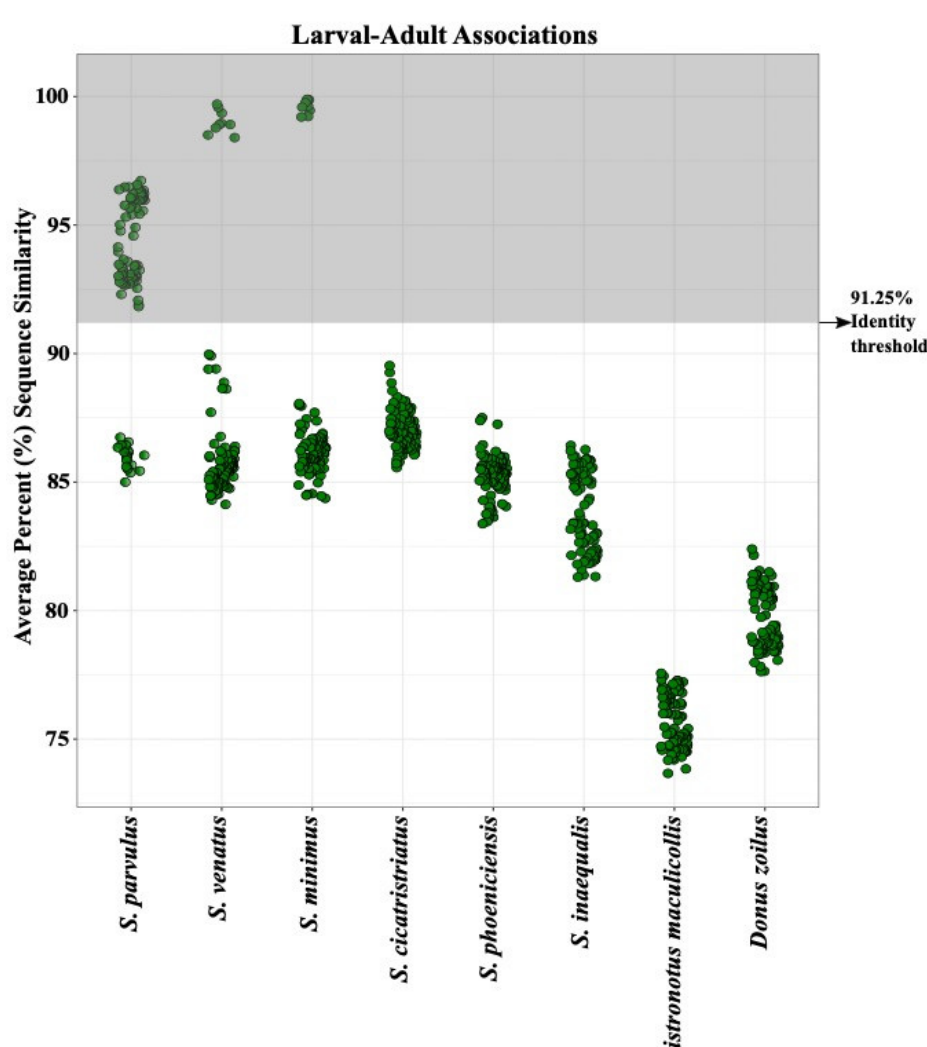
Figure 6. Pairwise distances between larvae and adults (Utah 2018 and Indiana 2020) measured as average percent sequence similarity of the COI gene (640 bp). Each green dot represents a larval sequence matched against the adult reference database sequences (i.e., above the 91.25% mark in the gray area of figure). Larval sequences are compared to all sequences of each species included in the reference database: Sphenophorus parvulus , S. venatus , S. minimus , S. cicatristriatus , S. phoeniciensis ,